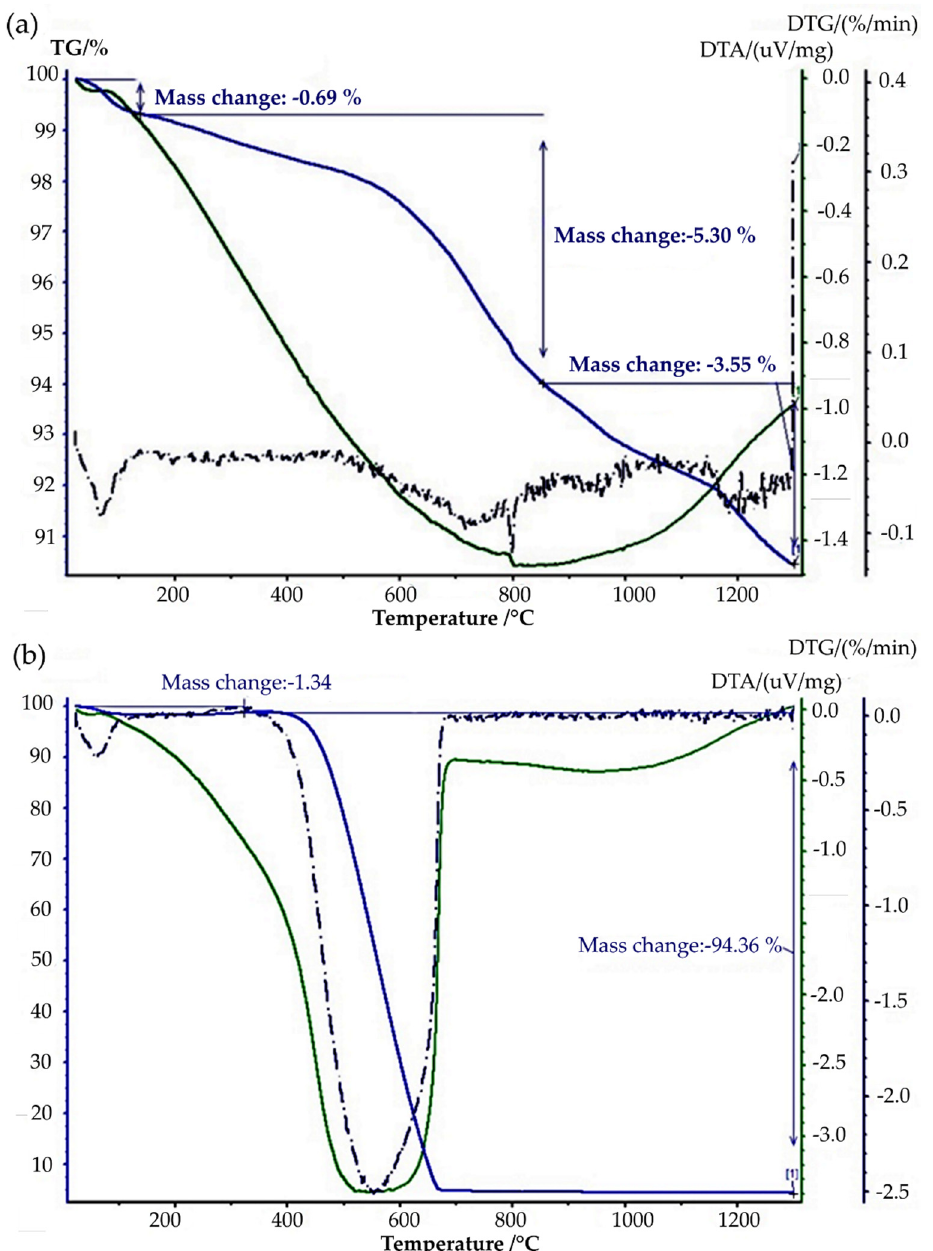
Figure 3. The thermogravimetric analysis of mineral part of the Yaregsky oil in argon ( a ) and in air ( b ). Thermogravimetric analysis (TG)-mass change; Differential thermogravimetric analysis (DTG)-decomposition rate; Differential thermal analysis (DTA)-mass change of the heat flux rate (shows the nature of the reaction exo or endothermic).